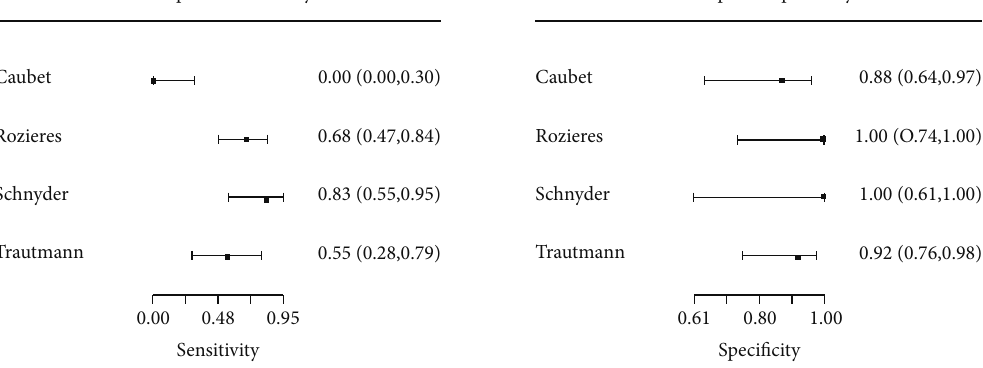
Figure 2: Meta-analysis of LTT ( SI > 2 : 5 ). Forest plots of sensitivity and speci fi